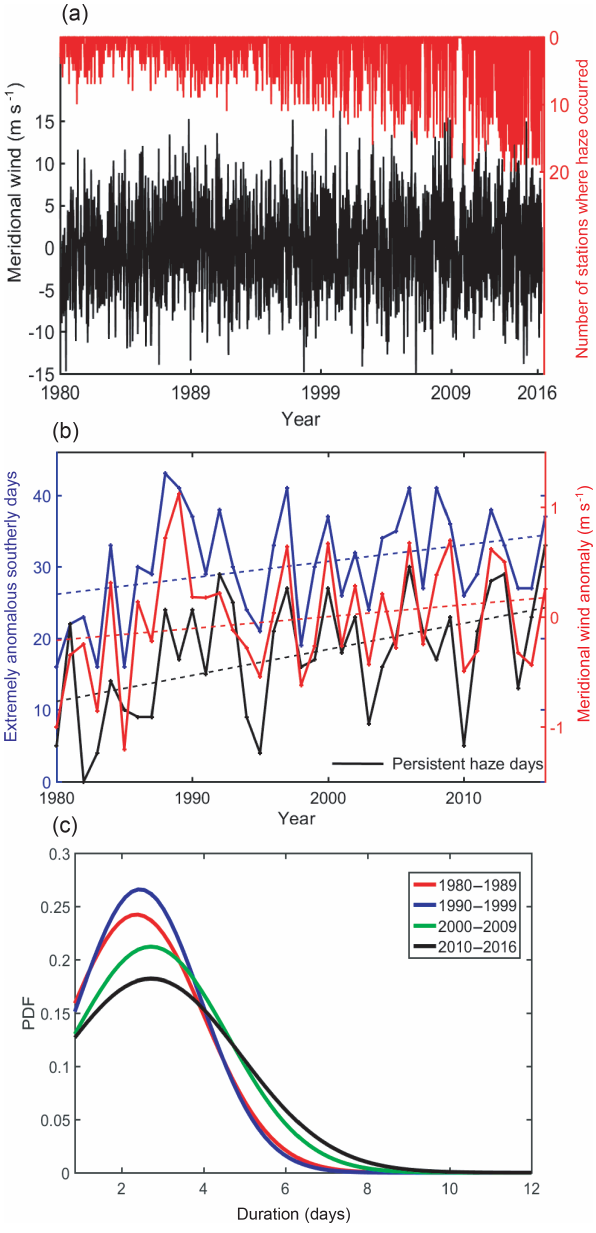
Figure 4. (a) Number of stations where haze is recorded in Bei- jing (red) versus daily meridional wind at 850hPa over the study region (30–50 ◦ N, 105–125 ◦ ) (black) in winter from 1980 to 2016. (b) Meridional wind anomaly (red), number of extremely anoma- lous southerly days (blue) and persistent haze days (black) in winter from 1980 to 2016. Dashed lines show the least-squares trends. (c) The PDF of the duration (days) of extremely anomalous southerly episodes for each decade from 1980 to